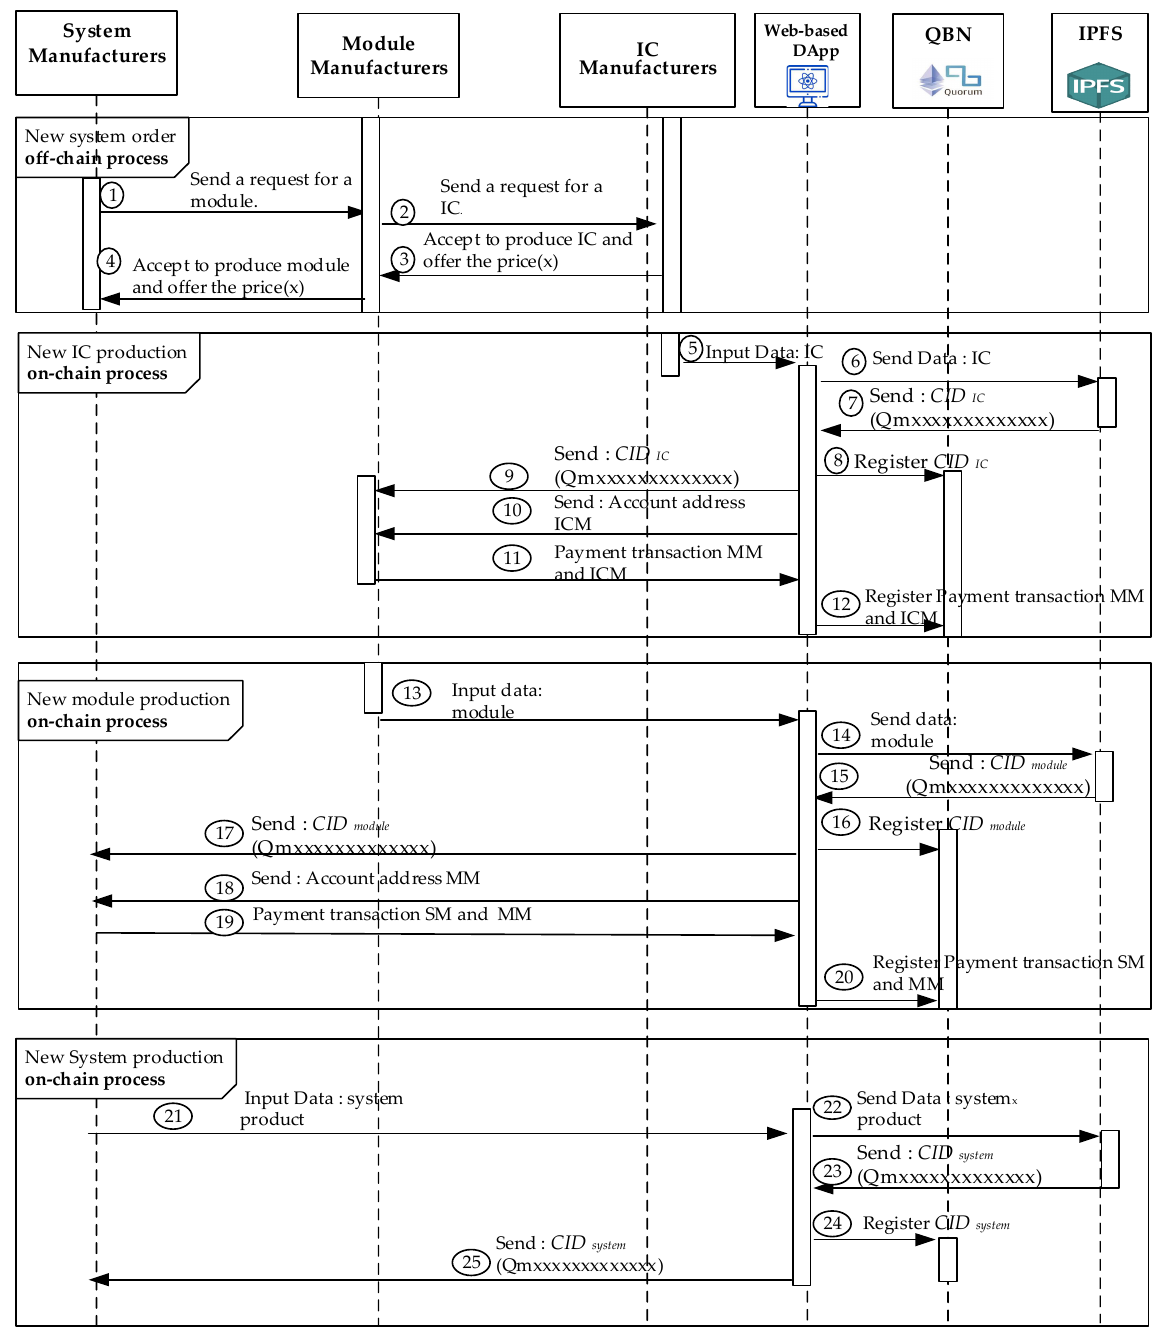
Figure 5. The sequence diagram of stakeholders in producing the system.